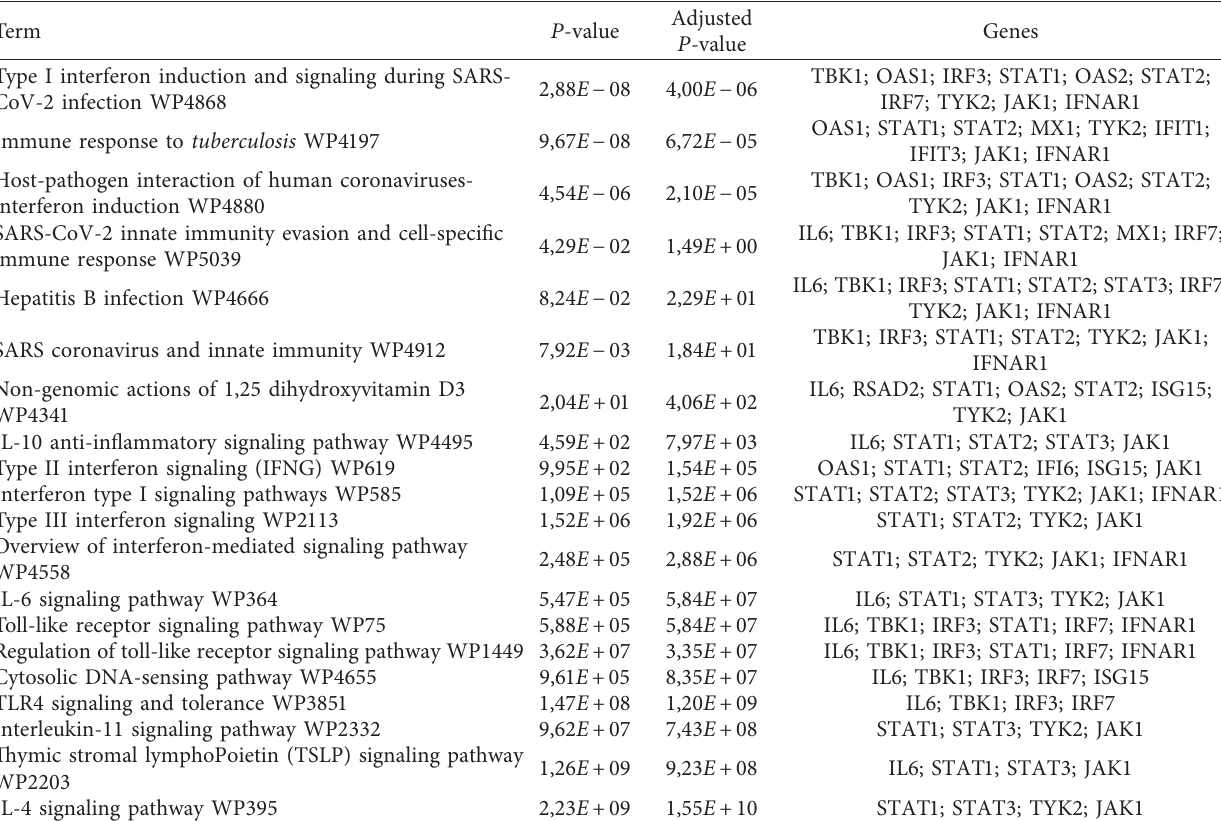
Table 3: Enriched data from WikiPathway